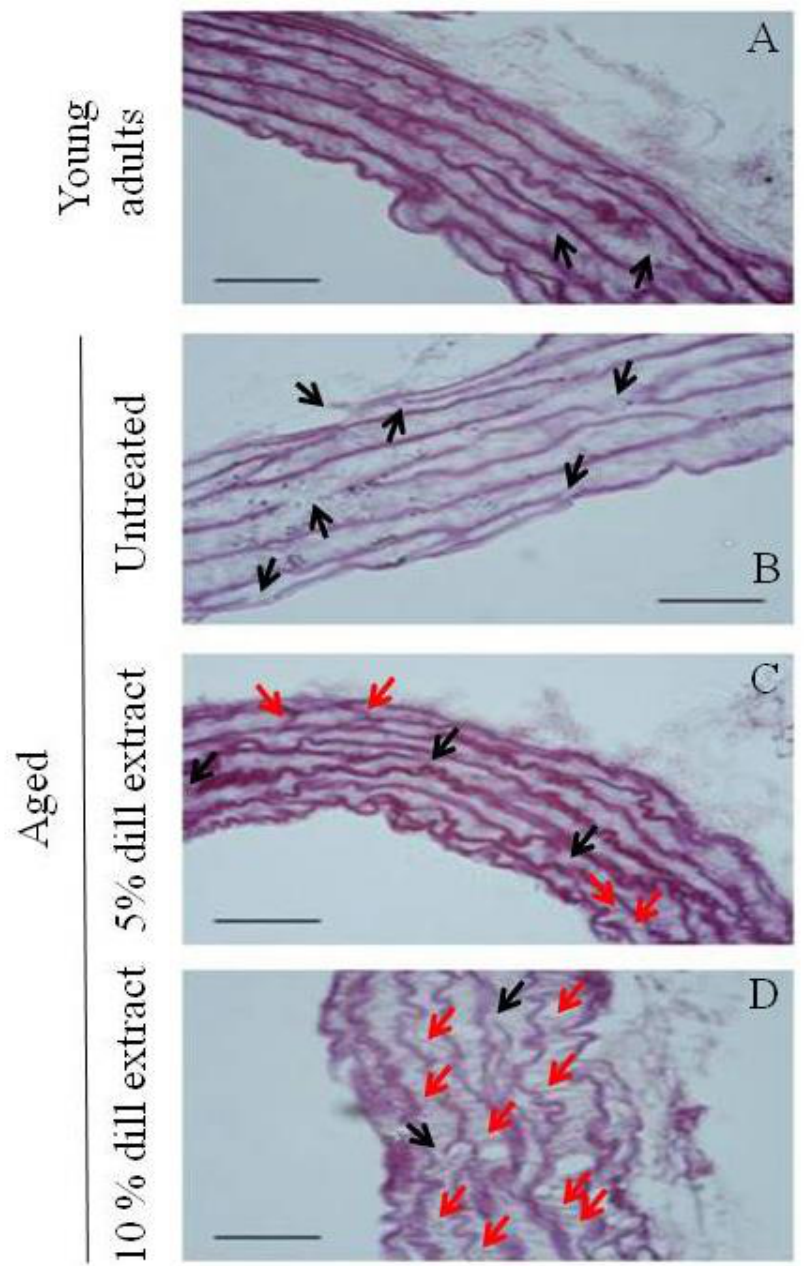
Figure 2. Histology of the ascending aorta from ( A ) untreated adult mice, ( B ) untreated aged mice, ( C ) 5% DE-treated aged mice, ( D ) 10% DE-treated aged mice. Cross-sections with Weigert staining of the elastic fibers. Bar = 50 µm. Black arrows: elastic lamella disruptions. Red arrows: neo-synthesized elastic fibers. n = 3 animals per group.